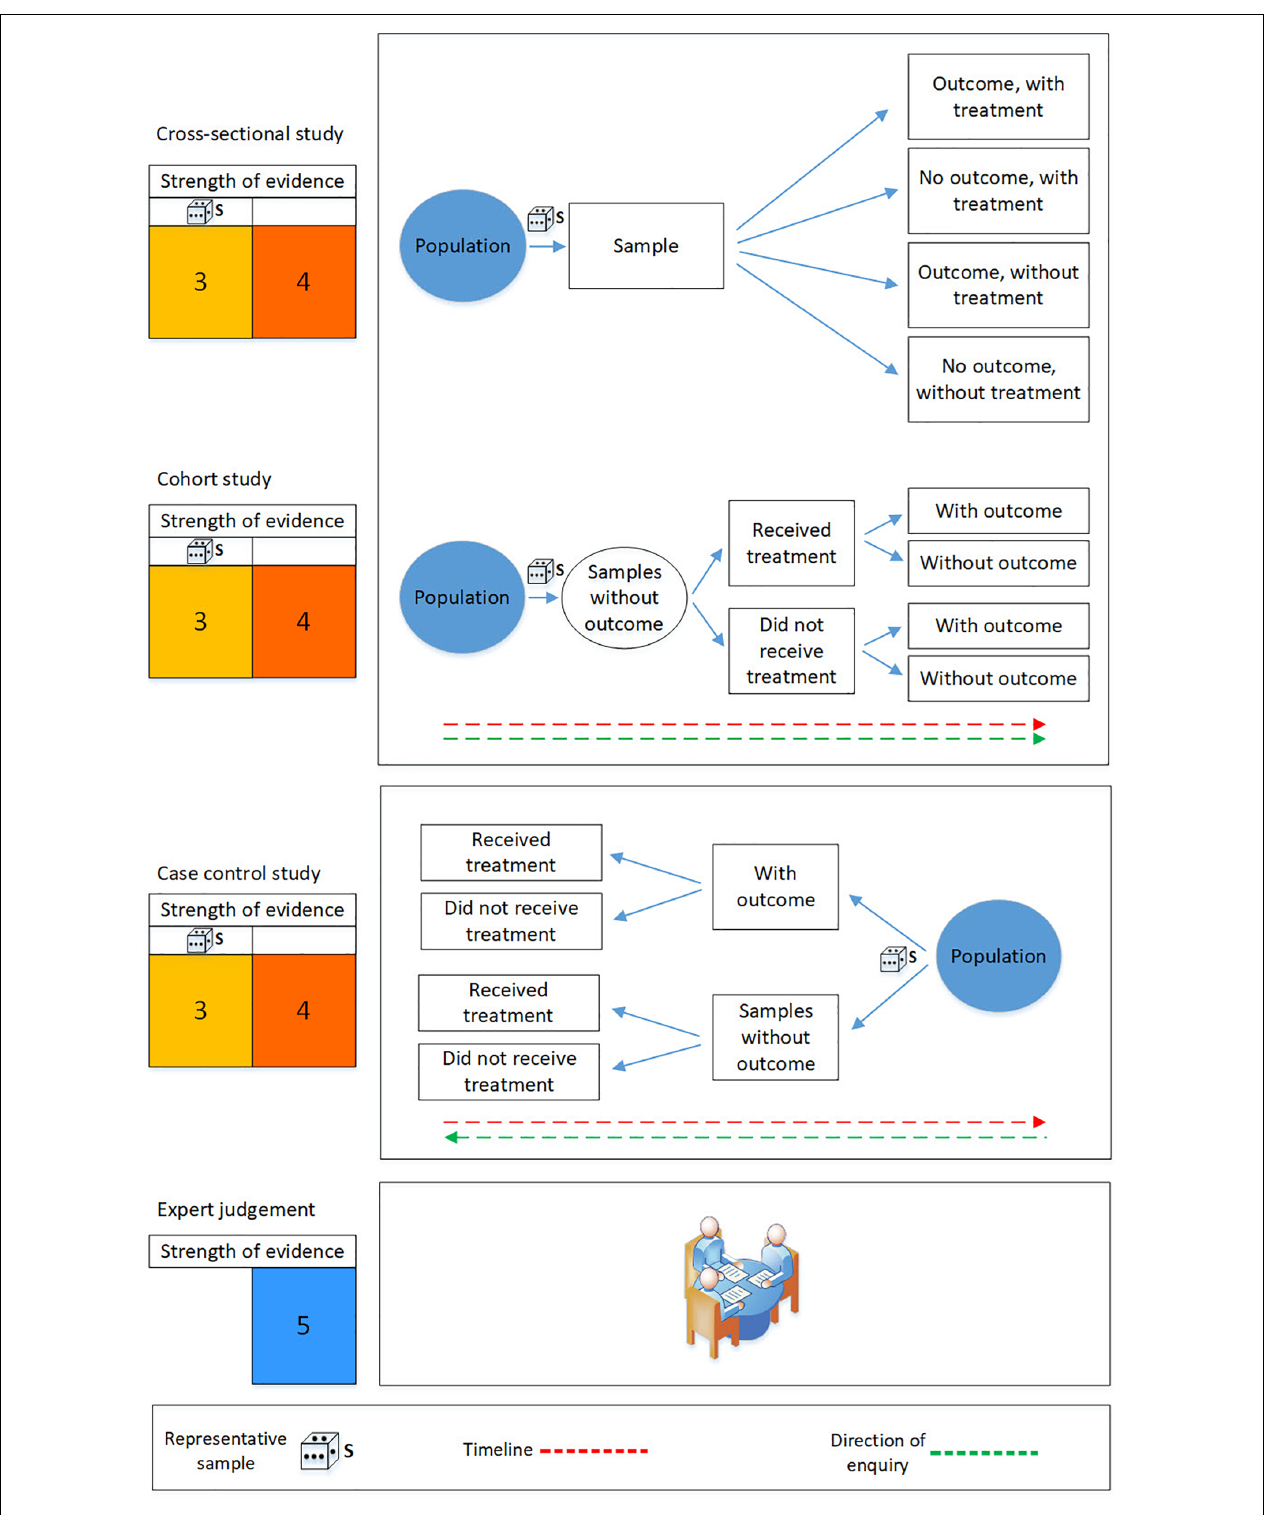
FIGURE 3 | Schematic illustration of the evidence hierarchy for observational studies and expert judgment. The die represents selection of a representative sample by, for example, a randomized sampling scheme. The strength of evidence is diminished if the sample is not representative of the target population (second column on the left). The colors in the columns to the left reflect the evidence hierarchies presented in Figure 1 . The strength of evidence is ranked from highest (1) to lowest (5). This figure is adapted from Wilson et al. (2015).